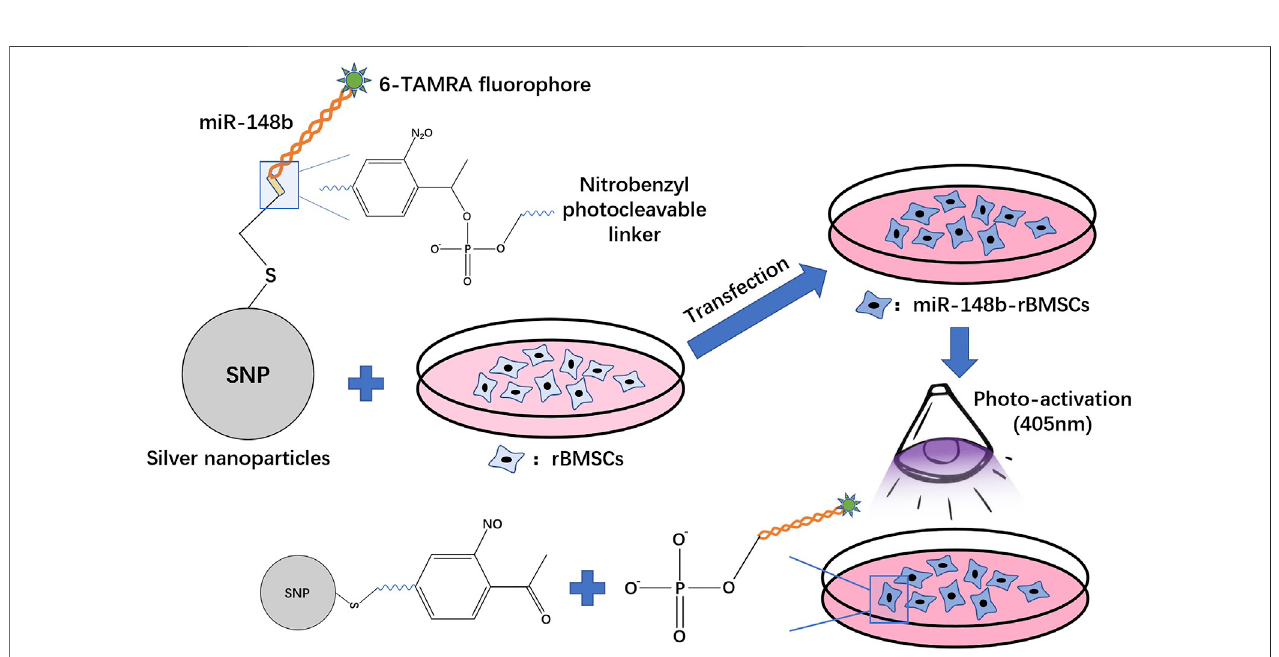
FIGURE 4 | The procession of silver nanoparticles (SNPs) with a nitrobenzyl photocleavable group transfecting miR-148b into rBMSCs.